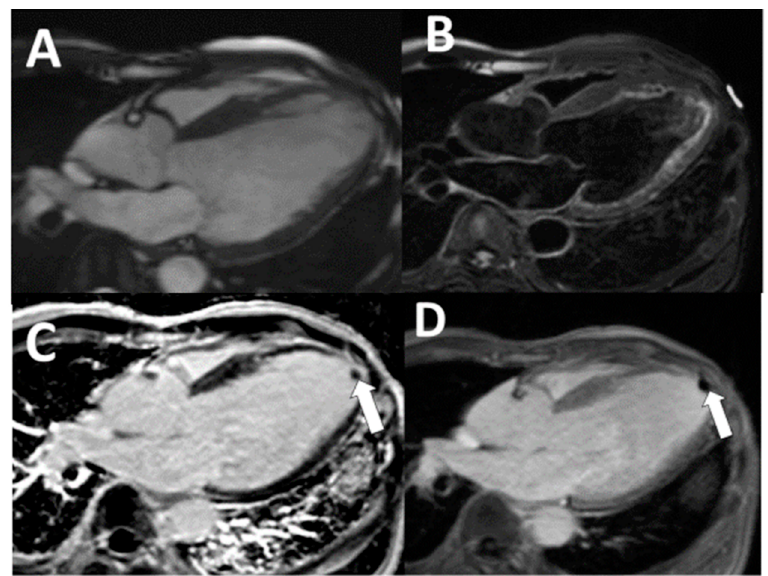
Figure 2. Example of false - negative cine - CMR and DB - CMR . Echocardiography was interpreted as negative ( not shown ). LV apical thrombus was not detected on ( A ) cine - CMR and ( B ) DB - CMR . LV apical thrombus was demonstrated on standard LGE - CMR with an inversion time of ( C : arrow ) 250 – 350 ms and ( D : arrow ) long inversion time with inversion time = 600 ms . This patient subsequently obtained antithrombotic medication after CMR . ( CMR : Cardiac magnetic reso- nance imaging, LGE - CMR : Late gadolinium enhancement sequence, DB - CMR : Dark blood sequence ).